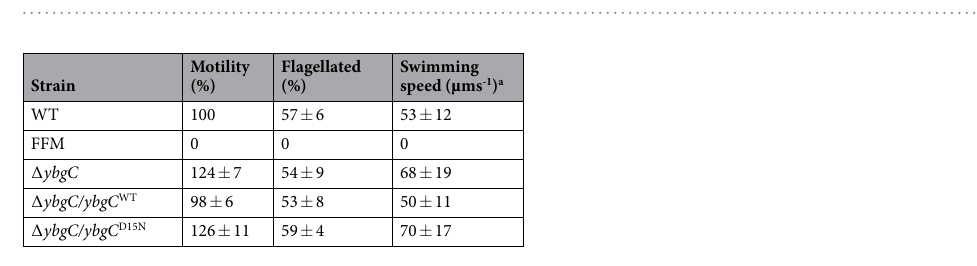
Table 2. Flagellar characteristics of S. oneidensis ybgC mutant. a A minimum of 100 cells were